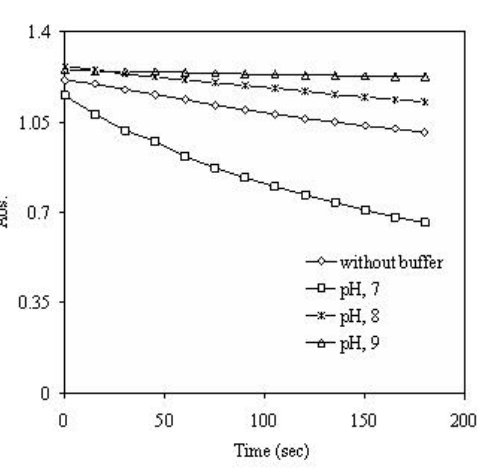
Fig. 6 Effect of pH on kinetic effect of S